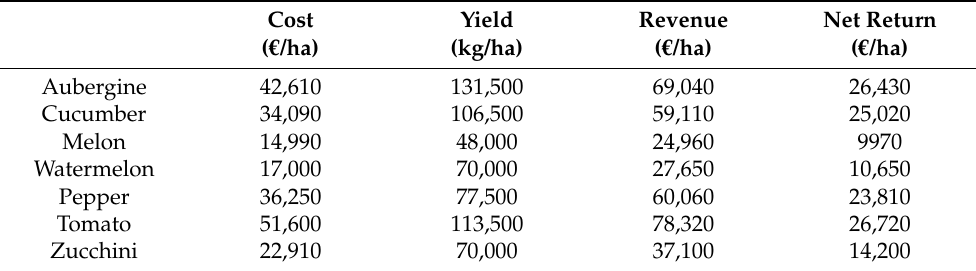
Table 3. Average Seinhorst parameters for main vegetable– M . incognita pathosystems. Tolerance Minimum Yield Net Return at Highest Crop Limit (%) RKN Pi ( € /ha)